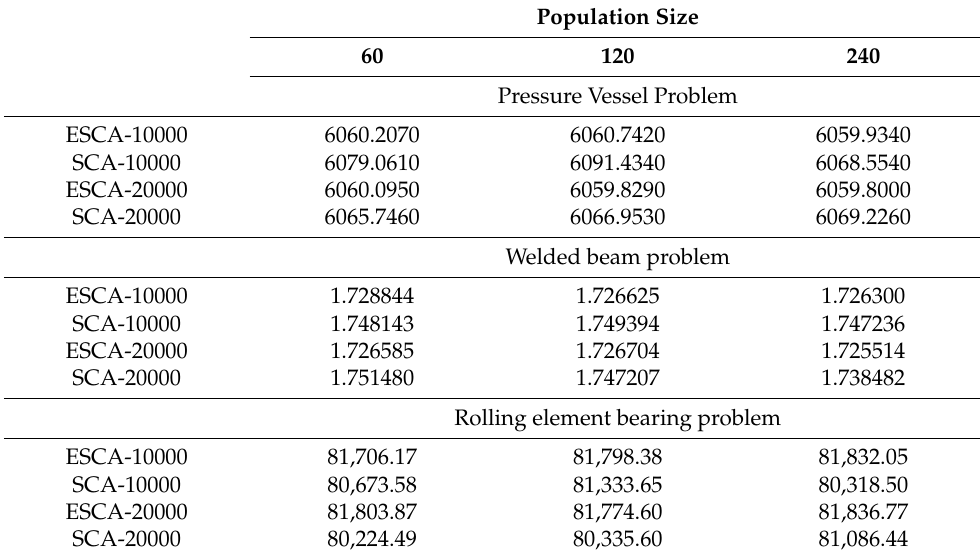
Table 14. Convergence ratio for ESCA and SCA algorithms with different population